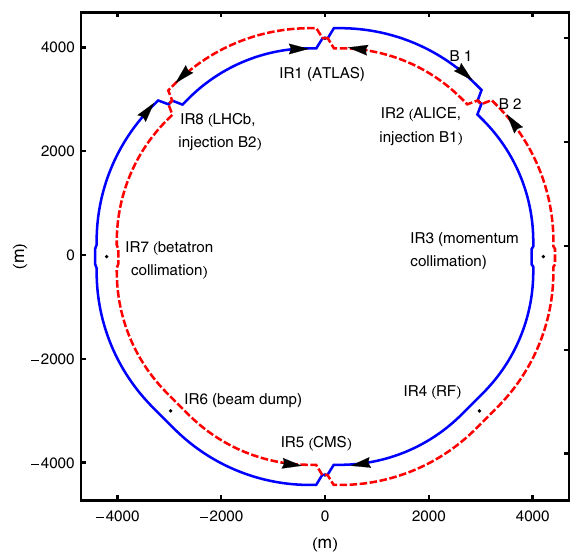
FIG. 2. The schematic layout of the LHC (the separation of the two rings is not to scale). The two beams collide at the four experiments ATLAS, ALICE, CMS, and LHCb. Adapted from Ref.